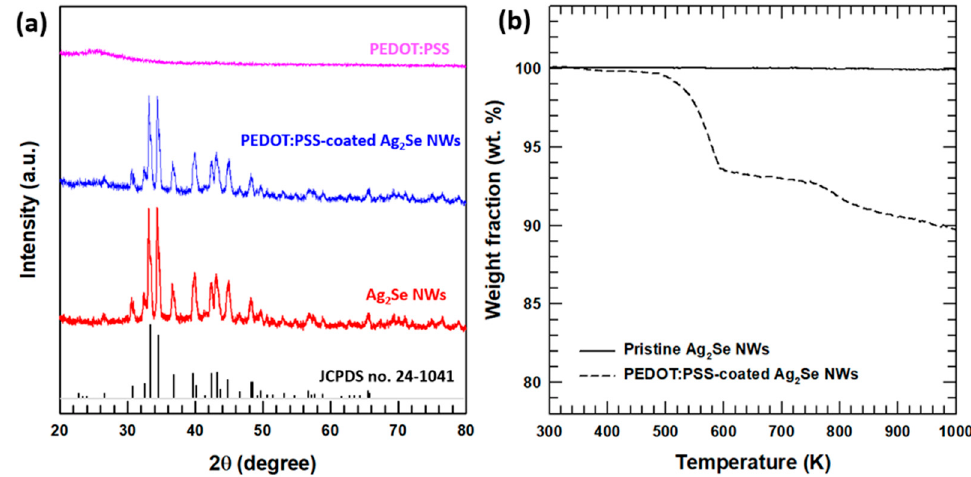
Figure 2. The characterization of the PEDOT:PSS-coated Ag2Se NWs and their synthetic intermediates: ( a ) the XRD patterns; ( b ) the TGA results.